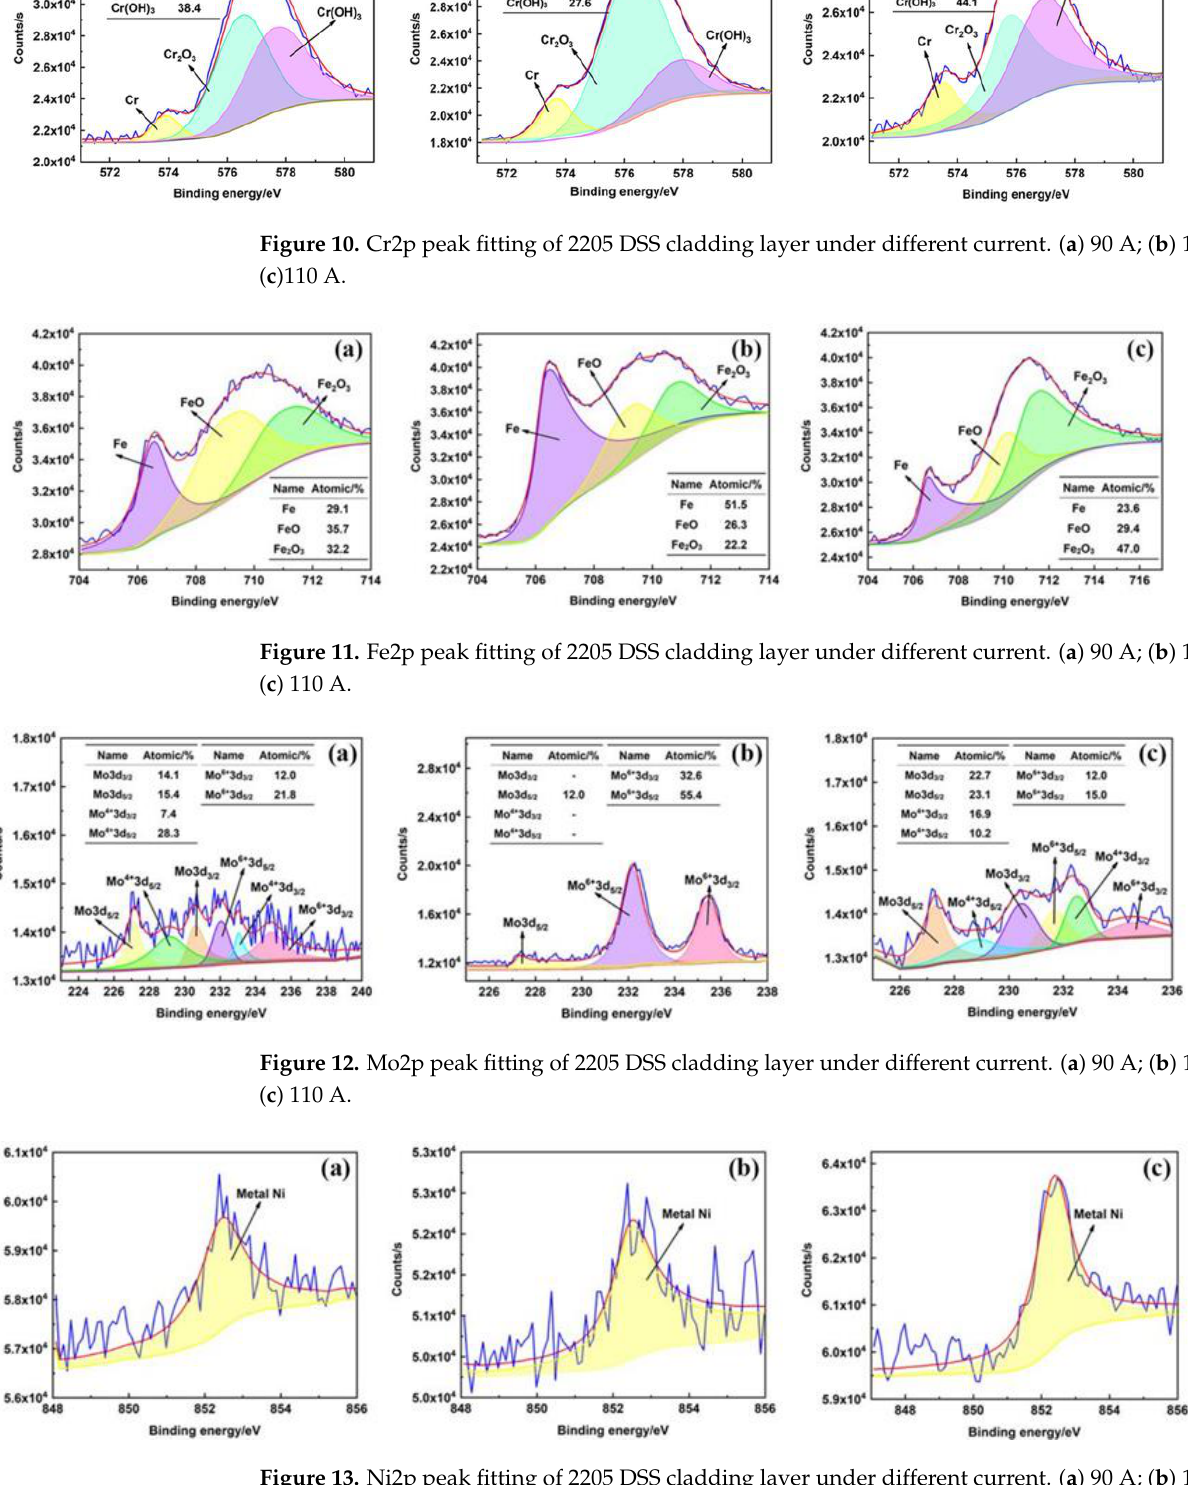
Figure 10. Cr2p peak fitting of 2205 DSS cladding layer under different current. ( a ) 90 A; ( b ) 100 A; ( c )110 A.